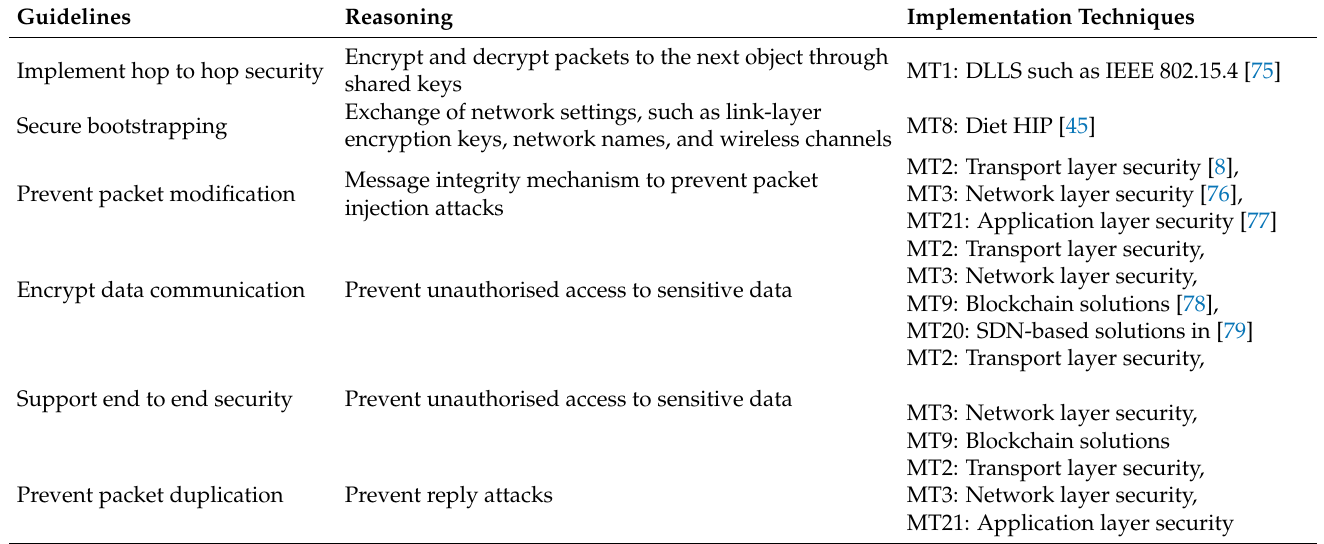
Table 7. A summary of the suggested guidelines for communication layer along with their